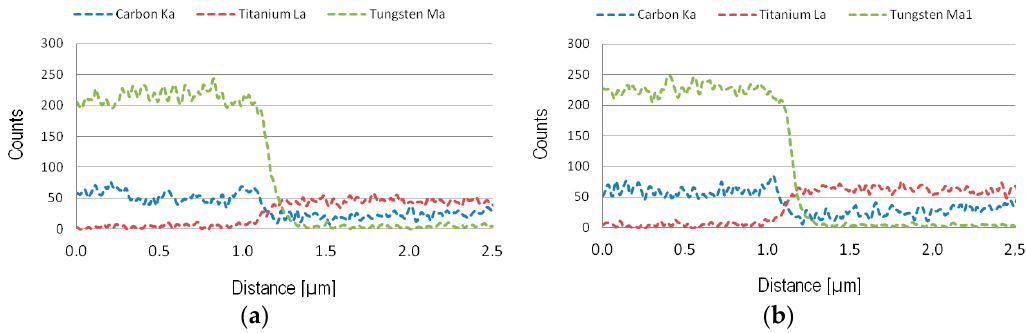
Figure 16. ( a , b ) EDS lines scans (E 0 = 5 keV) illustrating the concentration of C, Ti, and W from the cemented carbide towards the adhered work material. It should be noted that the Co signal shows a line scan profile similar to W and C but at a significantly lower intensity and therefore is excluded. High-resolution SEM and EDS analysis of the flank / work material interface show that also the wear of the flank is strongly dependent on the cutting conditions and that the prevailing wear mechanisms are the same as those at the rake face / chip